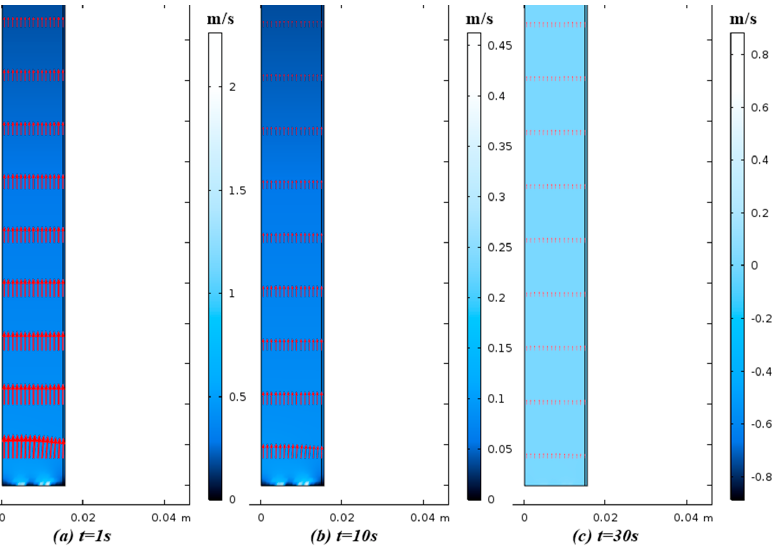
Figure 13. Internal velocity profile of adsorption column with inlet distributor at time = ( a ) 1 s; ( b ) 10 s; ( c ) 30 s.